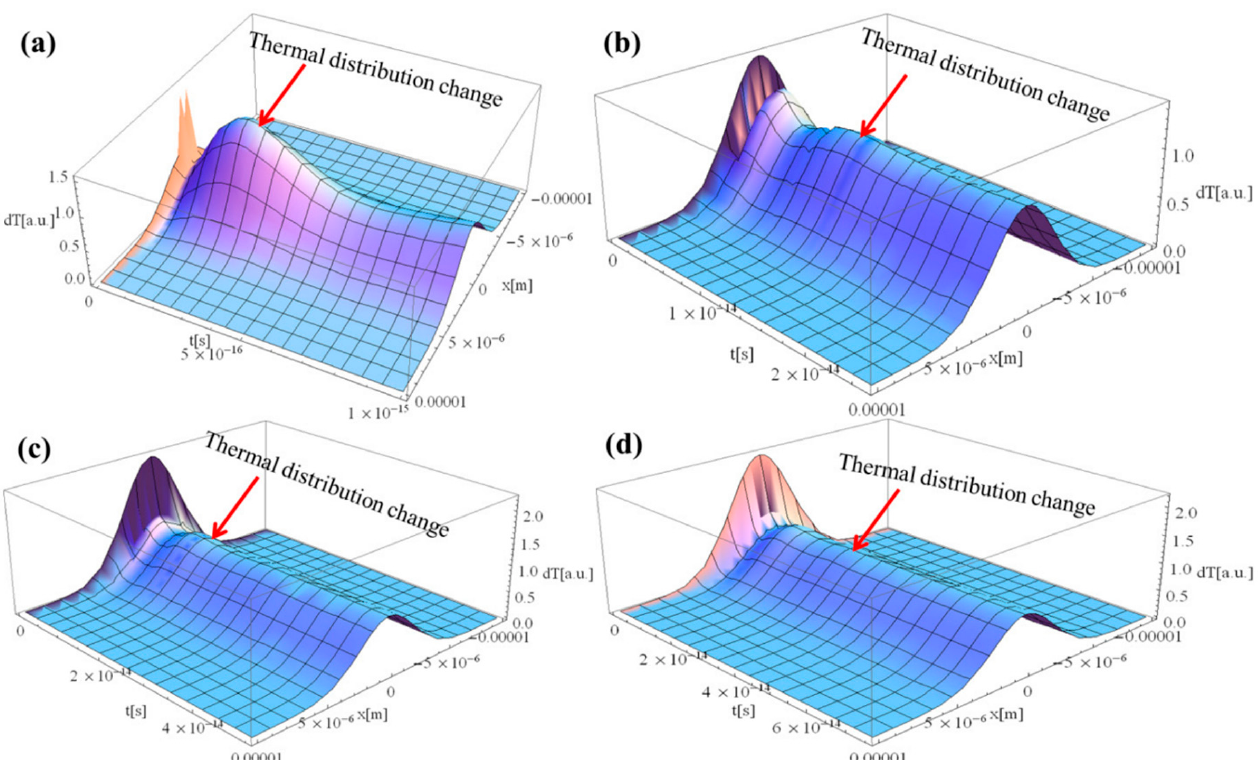
Figure 2. Laser–Al interaction for different duration of the laser pulse: ( a ) 1, ( b ) 25, ( c ) 50, and ( d ) 75 fs.